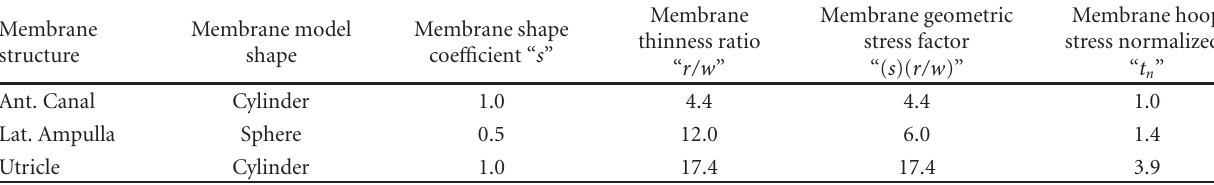
Table 2: Mean membrane parameters for the toadfish labyrinth ∗ .